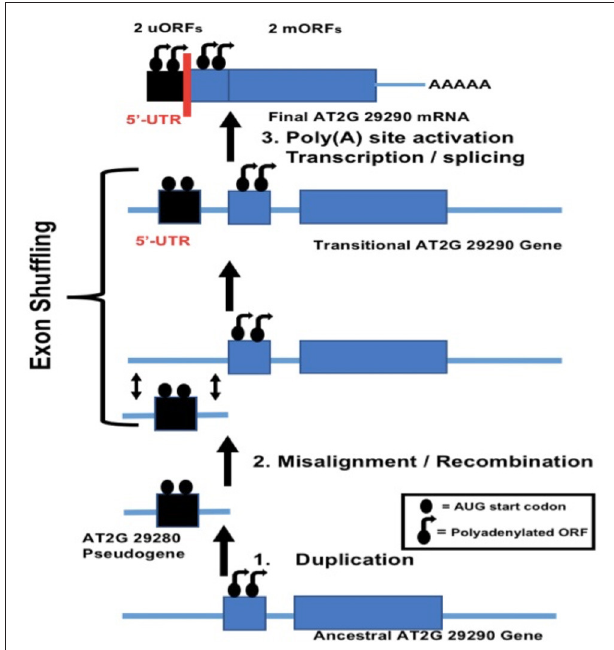
FIGURE 7 | Exon shuffling model for evolutionary origin of dual uORFs in AT2G29290 (gene no. 9). (1) Duplication of a region within the mORF’s 5 ′ -end containing the start codon produces a short pseudogene, shown as AT2G29280 in the annotated Arabidopsis genome database TAIR. (2) Misalignment and subsequent recombination with the original genomic copy results in a short upstream duplicate of the 5 ′ -end element. (3) Poly(A) site activation and subsequent transcription results in two mRNA products, a short one from the newly-acquired 5 ′ -uORF and the other, a longer mORF, arising from the original gene itself.